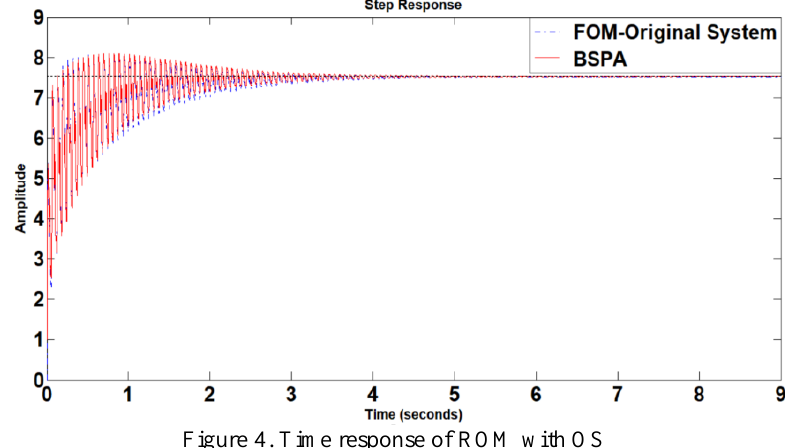
Figure 4. Time response of ROM with OS